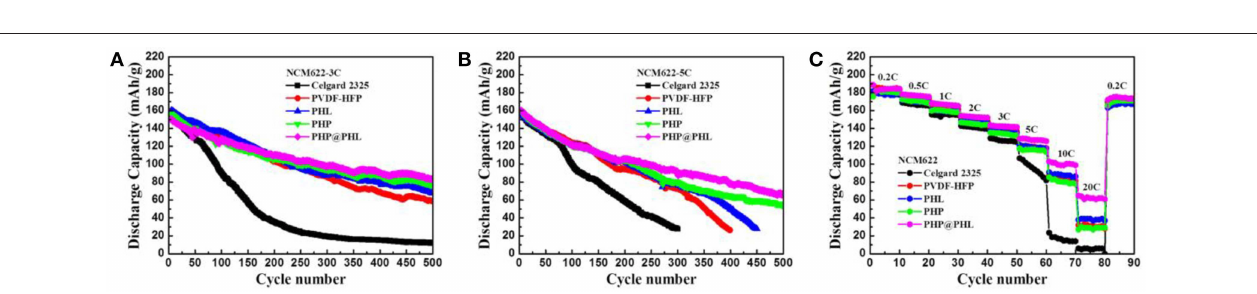
FIGURE 7 | Long-term cycling stability of the NCM622/Li cells with different membranes (Celgard 2325, PVDF-HFP, PHL, PHP, and PHP@PHL) at 3C rate (A) , 5C rate (B) , and their rate capability (C)